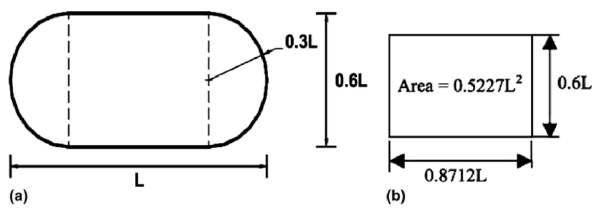
Figure 4: (a) Contact area between tires and the pavement surface; (b) equivalent contact area [46, 50]